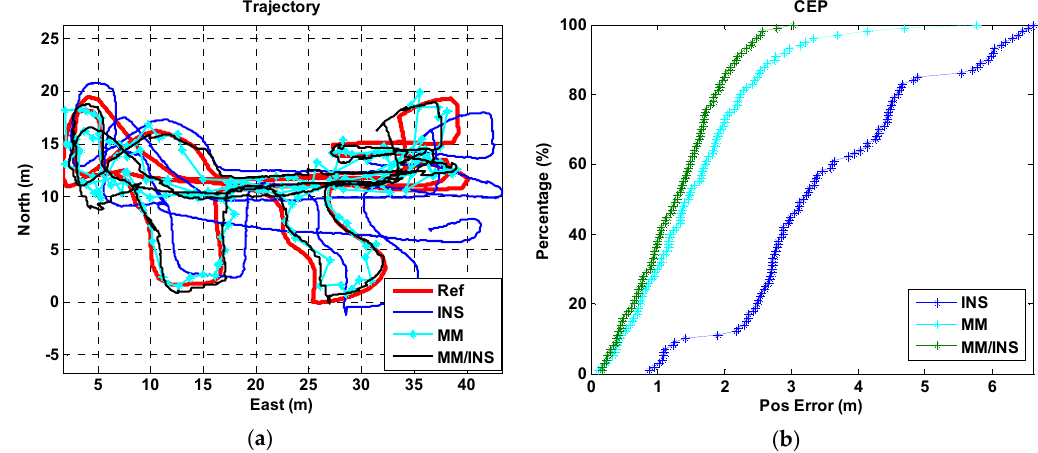
Figure 11. Navigation results of the INS, MM, and MM/INS solutions in building B (Test III: Pedestrian III, Trajectory II, Google Pixel 2). ( a ) Trajectories; ( b ) cumulative error percentages.